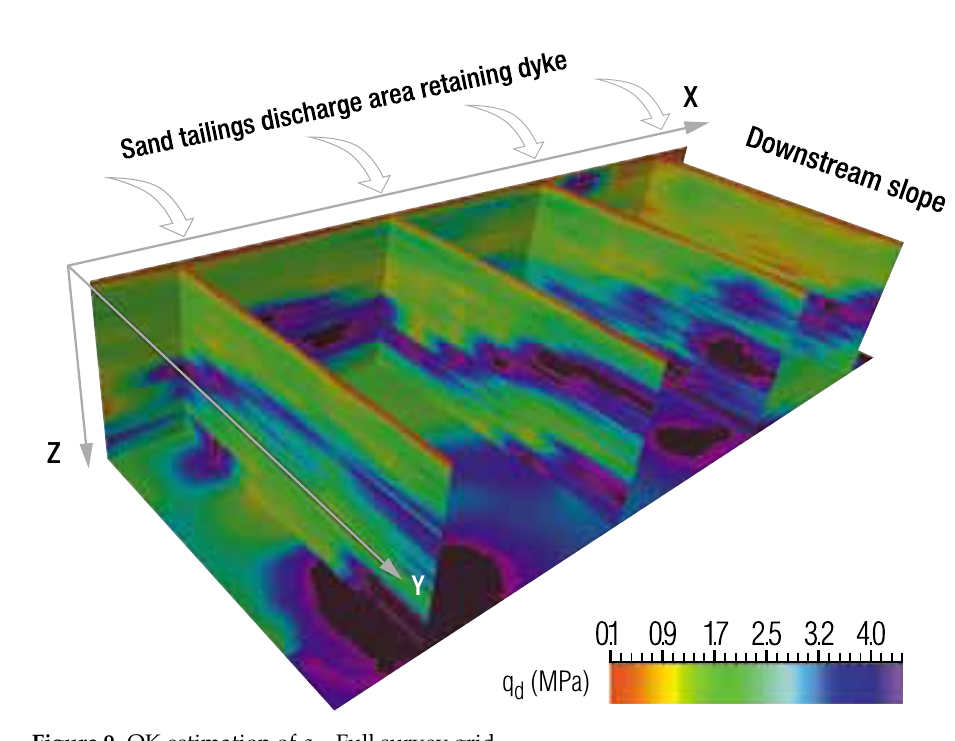
Figure 9. OK estimation of q d . Full survey grid.